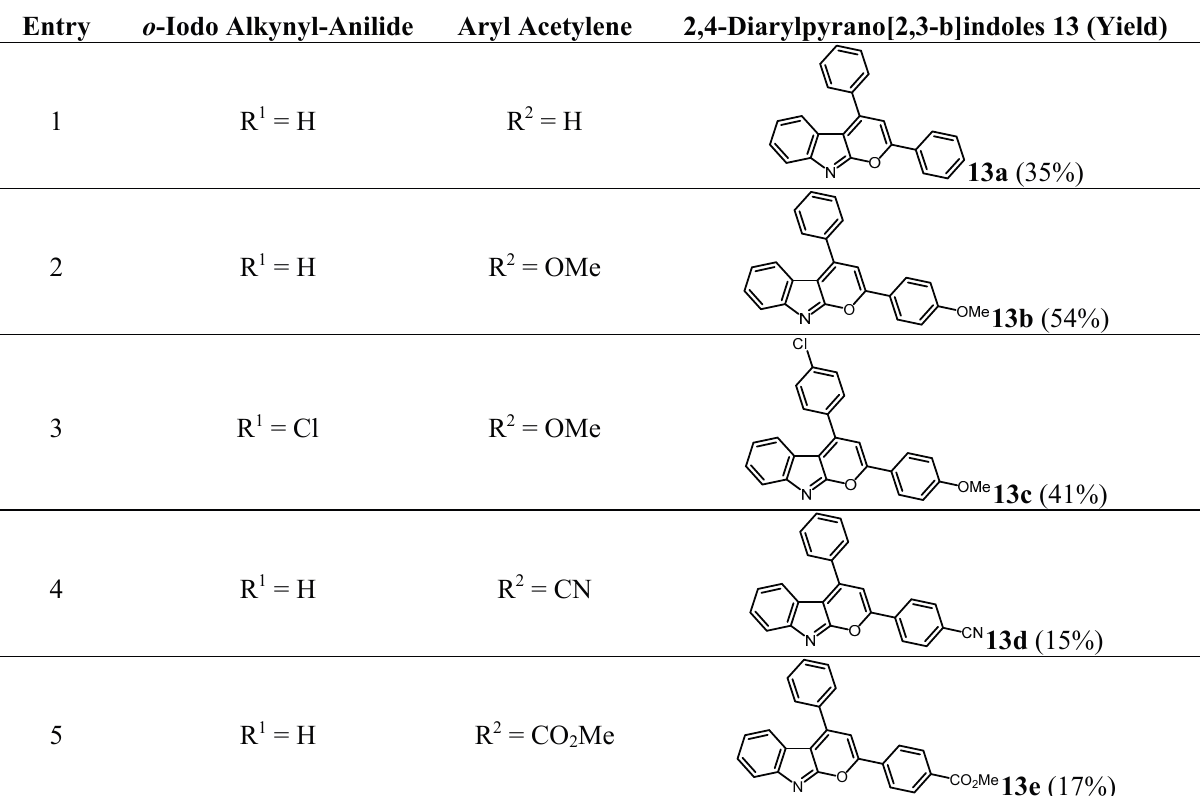
Table 4. Selected 2,4-diarylpyrano[2,3- b ]indoles 13 prepared via sequentially